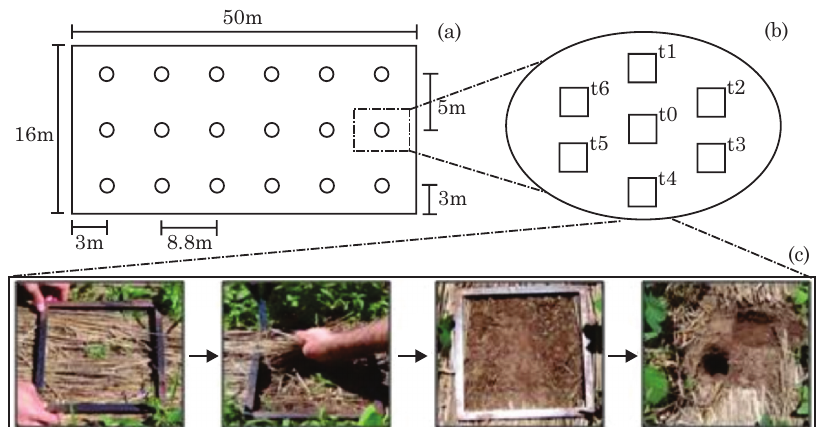
Figure 2. Diagram of the sampling procedure. (a) The experimental plot and collection points for each sampling time. (b) Alternate collection sites for each sampling time at the same sampling point. (c) Collection of crop residue and soil samples.